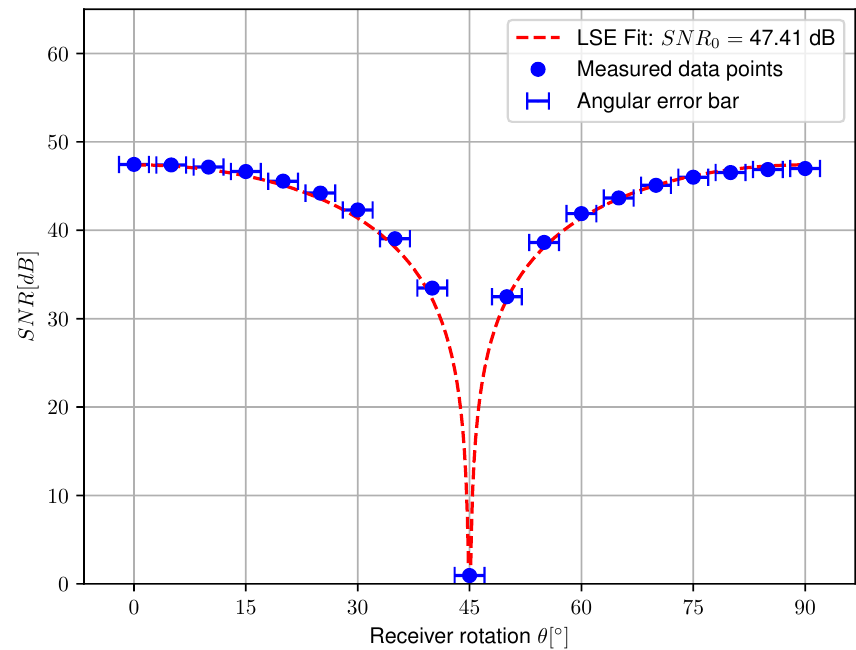
( b ) Measured SNR and theoretical fit as a function of receiver rotation θ at h = 1.35m for transmitted ‘0’-bits, for setup A [17]. Figure 11. Measured SNR and theoretical fit as a function of receiver rotation θ at h = 1.35m for transmitted ‘1’-bits (top) and ‘0’-bits (bottom), for setup A